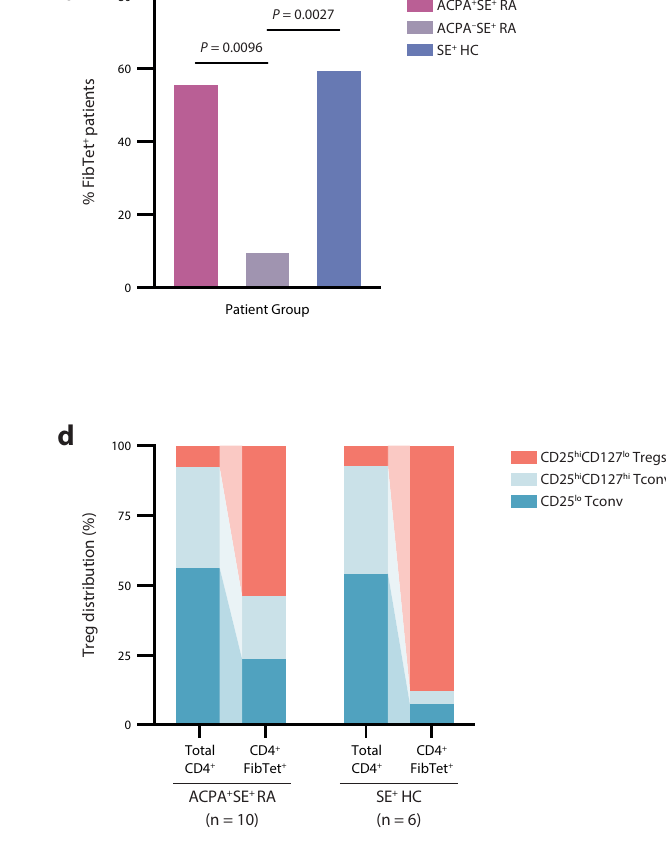
Fig. 7 | ACPA + SE + RA patient CD4 + T cells speci fi c for citrullination-dependent epitopes tend to be activated effector memory cells. a MHC class II tetramers containing three created fi brinogen peptides derived from NAPA (Fig. 5a) were used to stain PBMCs from ACPA + SE + RA patients ( n =18), ACPA – SE + RA patients ( n =10), and SE + healthy controls ( n =10). The percentage of fi brinogen tetramer – positive (FibTet + ) CD4 + T cellsare shown foreach patient group, and the dotted line denotes the positivity threshold of 0.5547%. Data are presented as